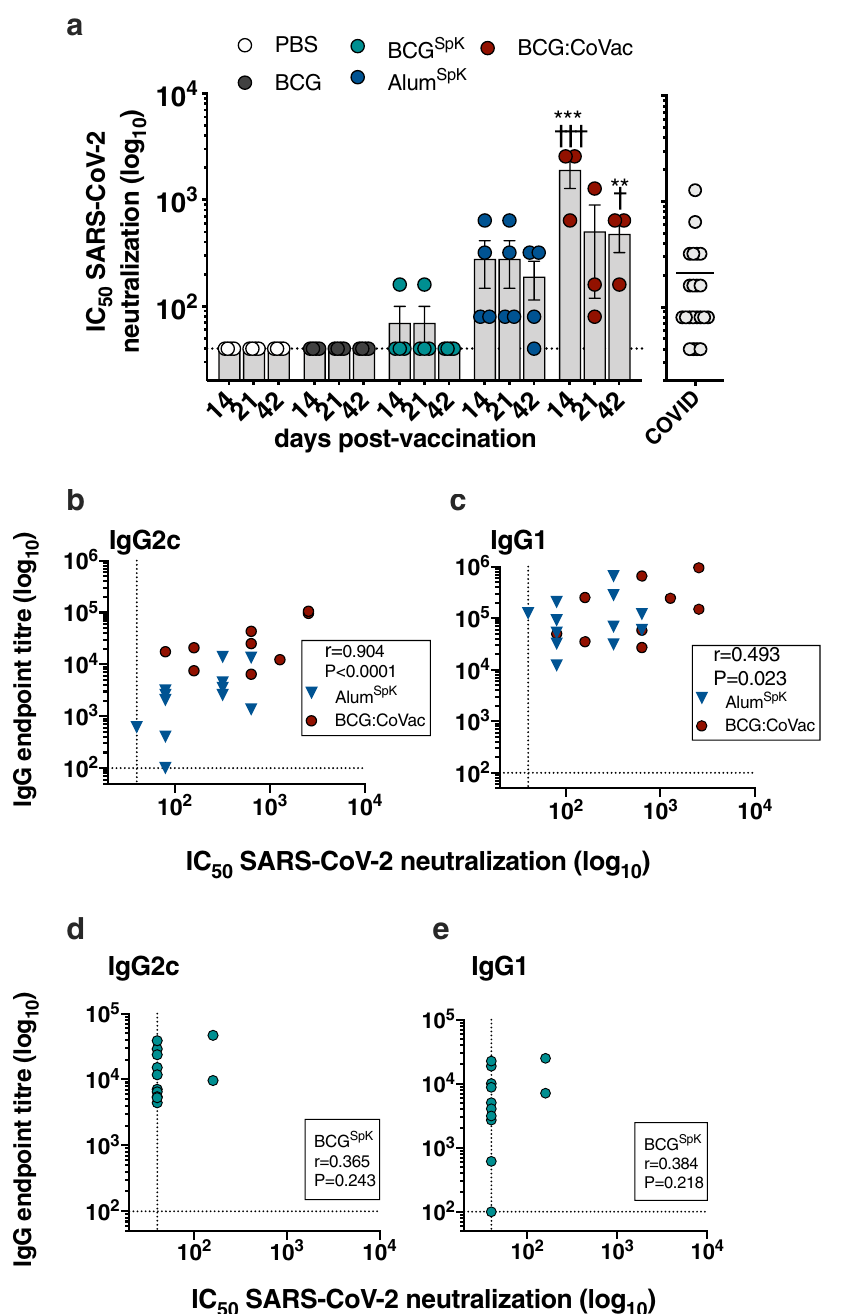
Fig. 3 BCG:CoVac induces high-titre neutralising antibodies against live SARS-CoV-2 that correlate with the production of antigen- speci fi c IgG2c. a – e Plasma from vaccinated mice (from Fig. 1) were tested for neutralising activity against live SARS-CoV-2 infection of VeroE6 cells. a Neutralising antibody (NAb) titres (IC 50 ) were calculated as the highest dilution of plasma that still retained at least 50% inhibition of infection compared to controls. NAb titres from PCR con fi rmed SARS-CoV-2-infected individuals (COVID) were determined using the same method. b , c Spearman correlations of spike-speci fi c IgG2c or IgG1 titres and NAbs after Alum SpK or BCG:CoVac vaccination. d , e Correlation of IgG2c or IgG1 titres and NAbs after vaccination with BCG SpK . The dotted line shows the limit of detection. Data presented as mean ± SEM and is representative of two independent experiments. Signi fi cant differences between groups compared to BCG Spk ** p < 0.01, *** p < 0.0 or Alum Spk † p < 0.05, ††† p < 0.001 was determined by one-way